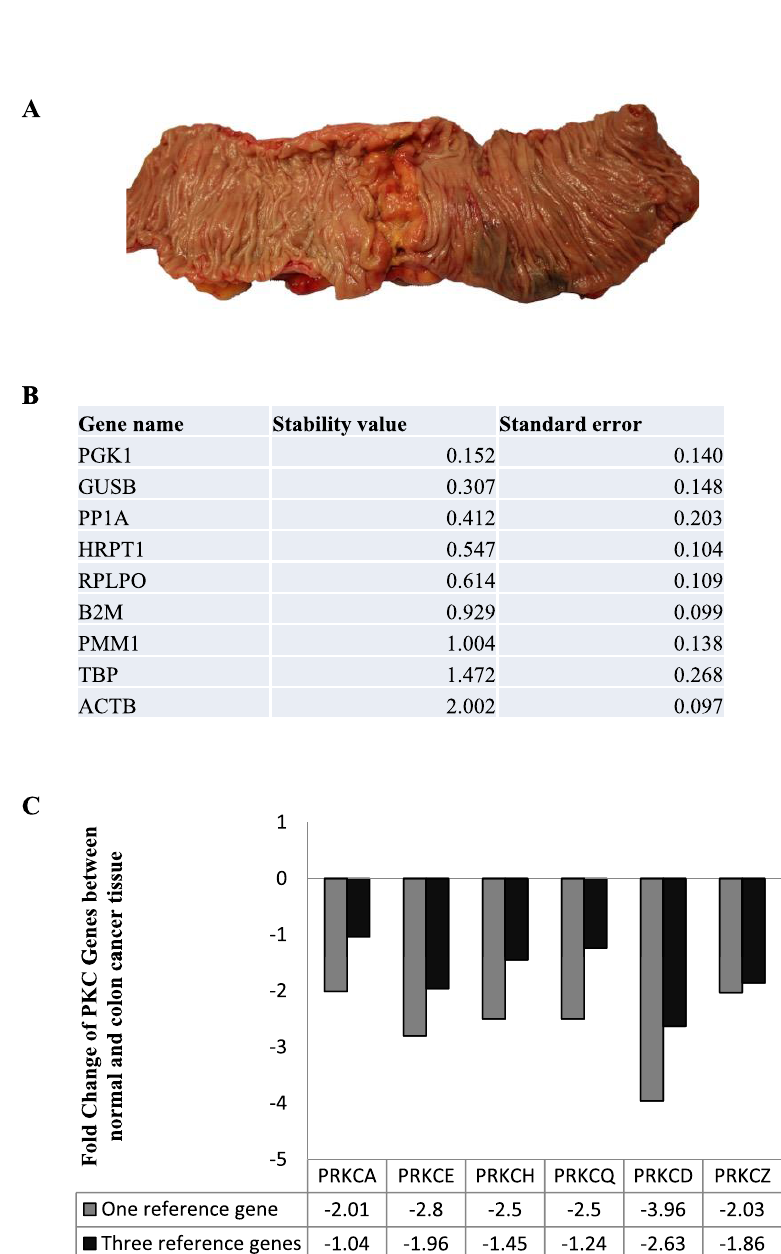
Figure 3. Reference genes in normal and colon cancer tissue. The stability of the nine candidate reference genes between normal and cancer tissue was analysed using NormFinder. ( A ) Surgical image of specimen resected from a colon cancer patient. ( B ) Table displaying the stability levels of the nine candidate reference genes between the normal and cancer tissue. ( C ) Graph representing the fold change of PKC coding genes in cancer tissue compared to normal tissue (n=21) when using one reference gene (PGK1) versus three reference genes (PGK1, GUSB and